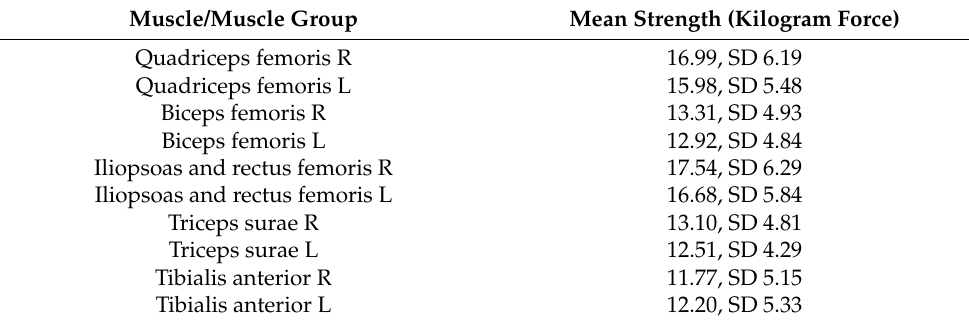
Table 5. Lower extremities muscle strength.